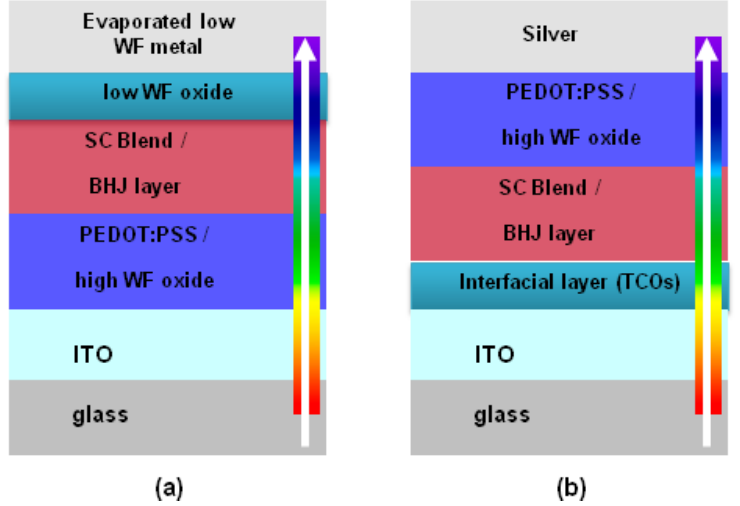
Figure 2. ( a ) Schematic device structure of the conventional polymer solar cell; and ( b ) schematic device structure of the inverted polymer solar cell. SC (Semiconductor); BHJ (inverted bulk heterojunction); PEDOT:PSS (polyethylene dioxythiophene:polystyrene sulfonate); ITO (indium tin oxide); WF (work